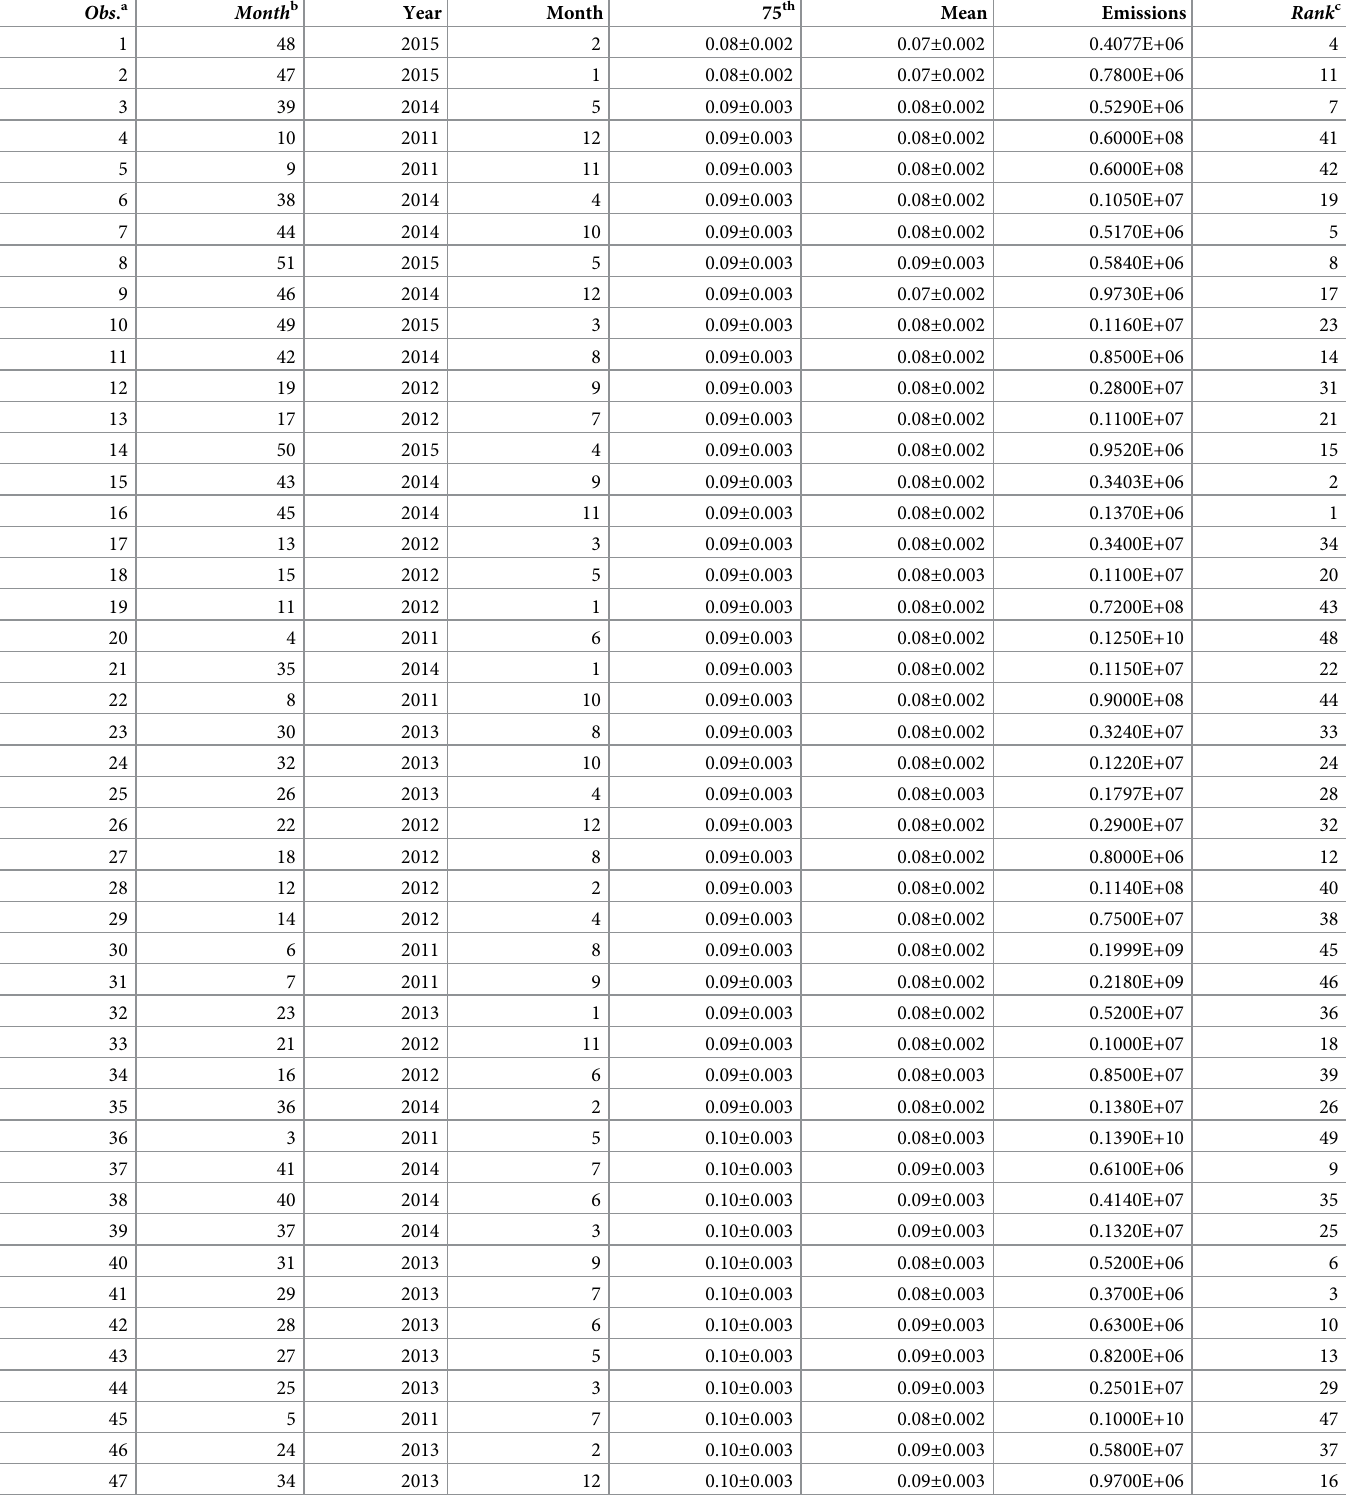
Table 2. List of monthly statistics of the 75 th , and mean air dose rates ( μ Sv/h); and the monthly FDNPS radiocesium emission fluxes (Bq/h). Obs .